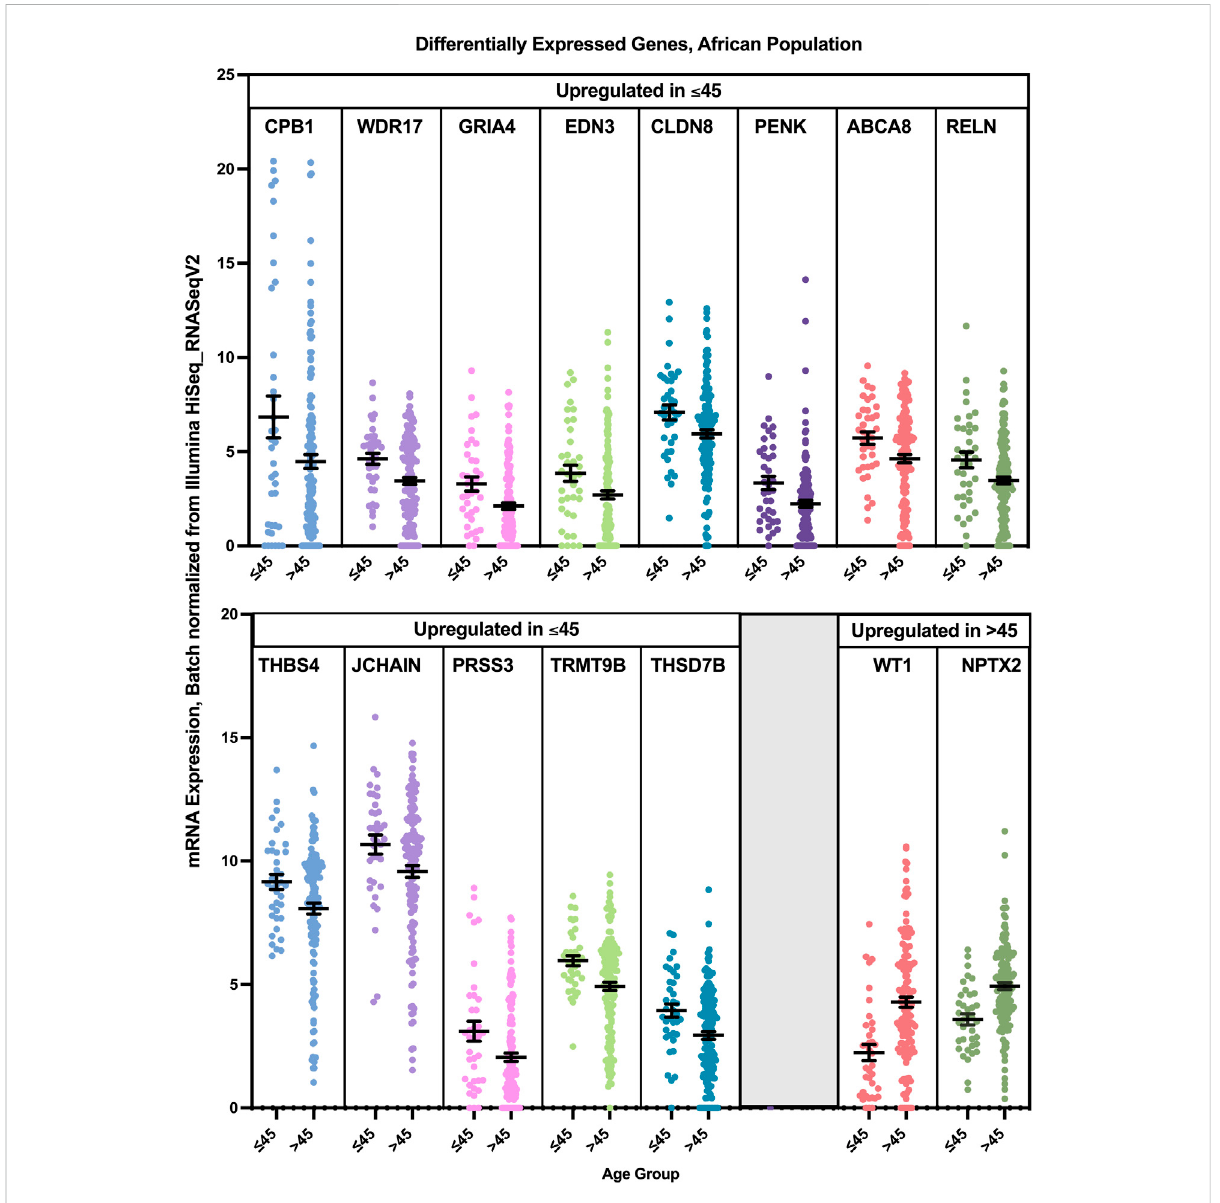
FIGURE 12 Differentially expressed genes in older and young patients of the Asian population ( p < 0.05, student ’ s t-test). Error bars represent Mean ±